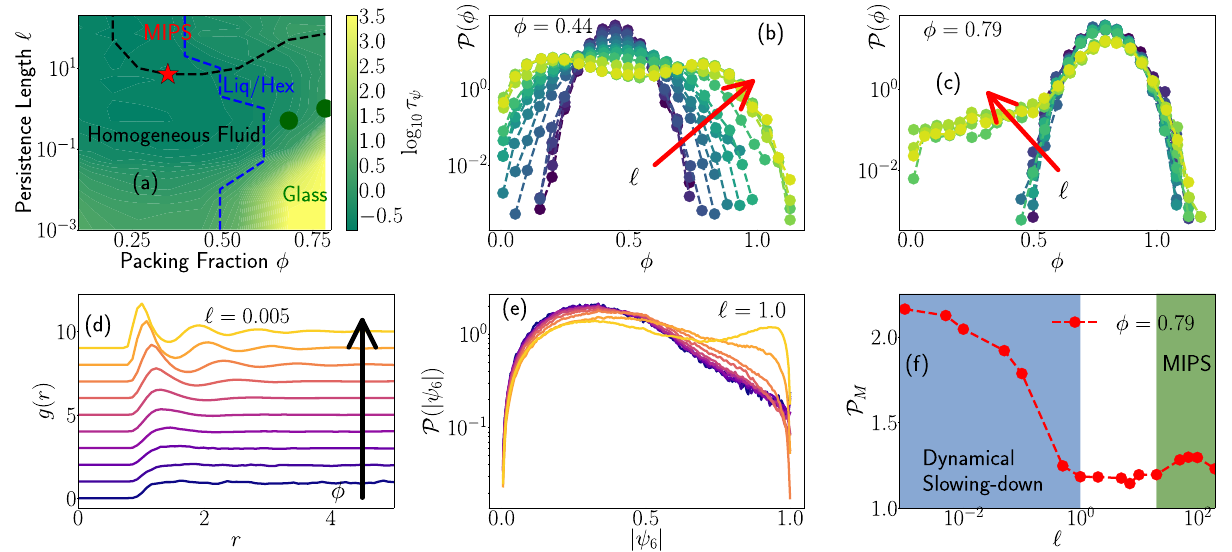
Fig. 2 Phase diagram of fully polydisperse Active Brownian particles. a The black dashed curve individuates the Motility-Induced Phase Separation (MIPS) coexistence region. The red star indicates the critical point. The blue dashed curve corresponds to the transition between homogeneous fl uid and liquid/hexatic coexistence. The color map indicates the relaxation time (in log scale). Green symbols indicate the typical persistent length corresponding to the smaller negative eigenvalue of the energy landscape. b Probability distribution function of the local packing fraction P ð ϕ Þ crossing the MIPS region ( ϕ = 0.44). The red arrows indicate increasing values of ℓ = 0.001, 0.005, 0.01, 0.05, 0.1, 0.5, 1, 2, 5, 7, 10, 20, 50, 70, 100, 200, from violet to yellow, respectively. c P ð ϕ Þ at high densities ( ϕ = 0.79), where the system undergoes a dynamical slowing down at low activities (the glass region in ( a )). Colors and persistence length values same as in ( b ). d Radial distribution function g ( r ) for small persistence length ( ℓ = 0.005) as density increases (as indicated by the black arrow, ϕ = 0.05, 0.09, 0.14, 0.20, 0.27, 0.35, 0.44, 0.54, 0.68, 0.79). For clarity, curves have been shifted vertically by 1 × n , with n = 0, 1, ..., 9 labelling each curve. Approaching the glass transition, g ( r ) does not reveal the presence of any solid-like positional order, as in the case of a fl uid. ( e ) jÞ at intermediate persistence length ( ℓ = 1.0) for increasing values of density, Probability distribution function of the hexatic order parameter P ðj ψ 6 (increasing values of density ϕ = 0.05, 0.09, 0.14, 0.20, 0.27, 0.35, 0.44, 0.54, 0.68, 0.79 from violet to yellow as in ( d )). Crossing the blue dashed line in jÞ as persistence length increases for ϕ = 0.79. The panel ( a ), the distribution develops a double-peaked structure. f Height of the high- ∣ ψ 6 ∣ peak of P ðj ψ 6 non-monotonous behavior (the peak decreases approaching a minimum value in the homogeneous phase and thus increases again in the MIPS region)